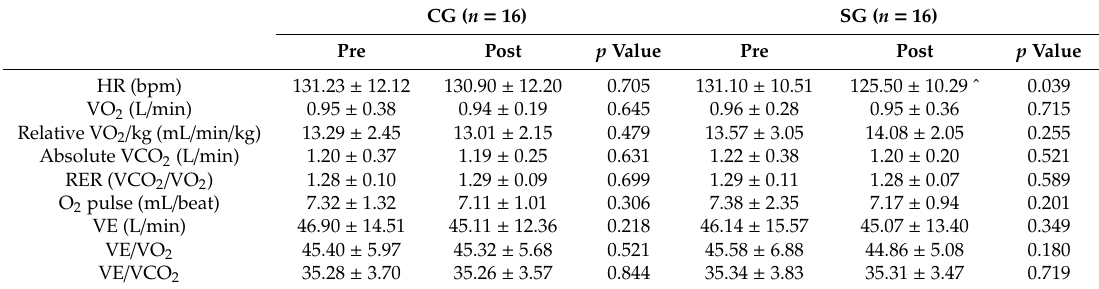
Table 7. Ergospirometric results obtained after three minutes of recovery.